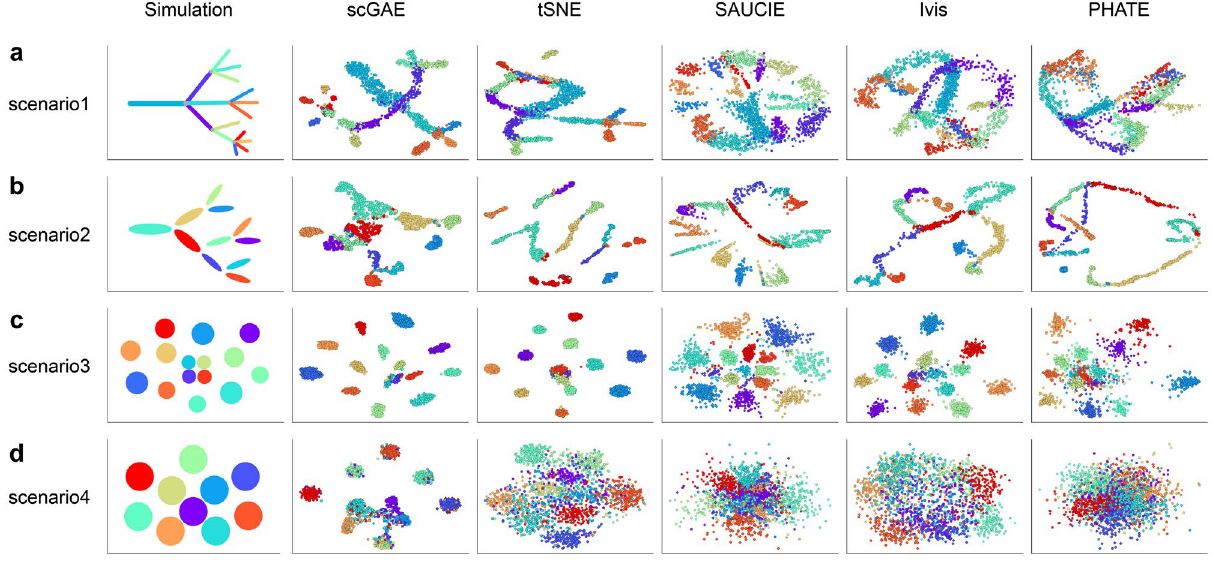
Figure 2. Visualization of the four simulated datasets by scGAE, tSNE, SAUCIE, Ivis, and PHATE. Each color represents a cell subpopulation in the simulated dataset. ( a ) scenario1: cells in continuous differentiation lineages. ( b ) scenario2: cells in differentiation lineages where cells concentrate at the center of each branch. ( c ) scenario3: distinct cell populations with apparent population differences. ( d ) scenario4: distinct cell populations with small population differences.